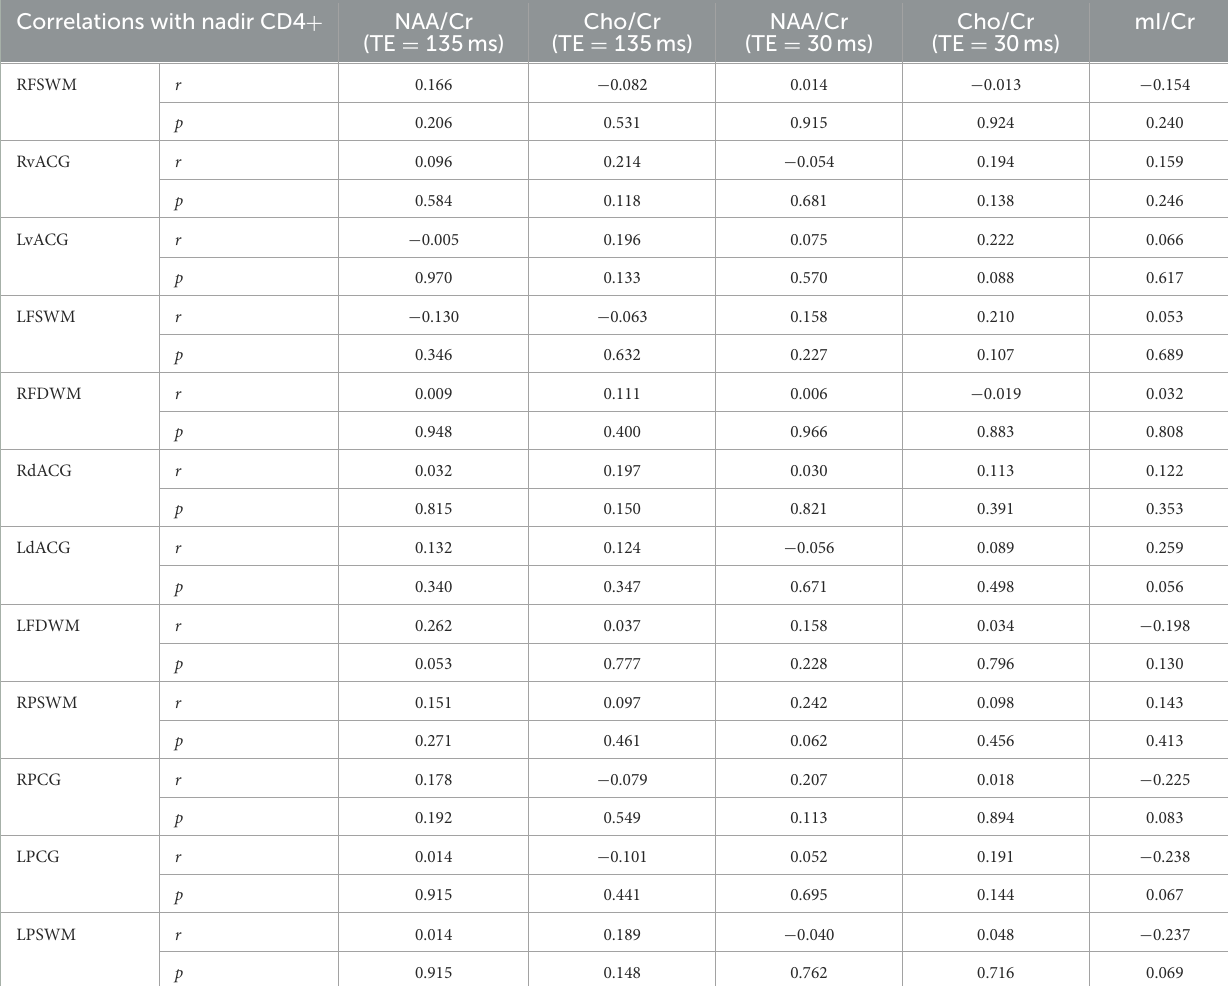
TABLE 5 Correlations of observed brain metabolites with nadir CD4 + T-cell count in analyzed locations. Correlations with nadir CD4 + NAA/Cr